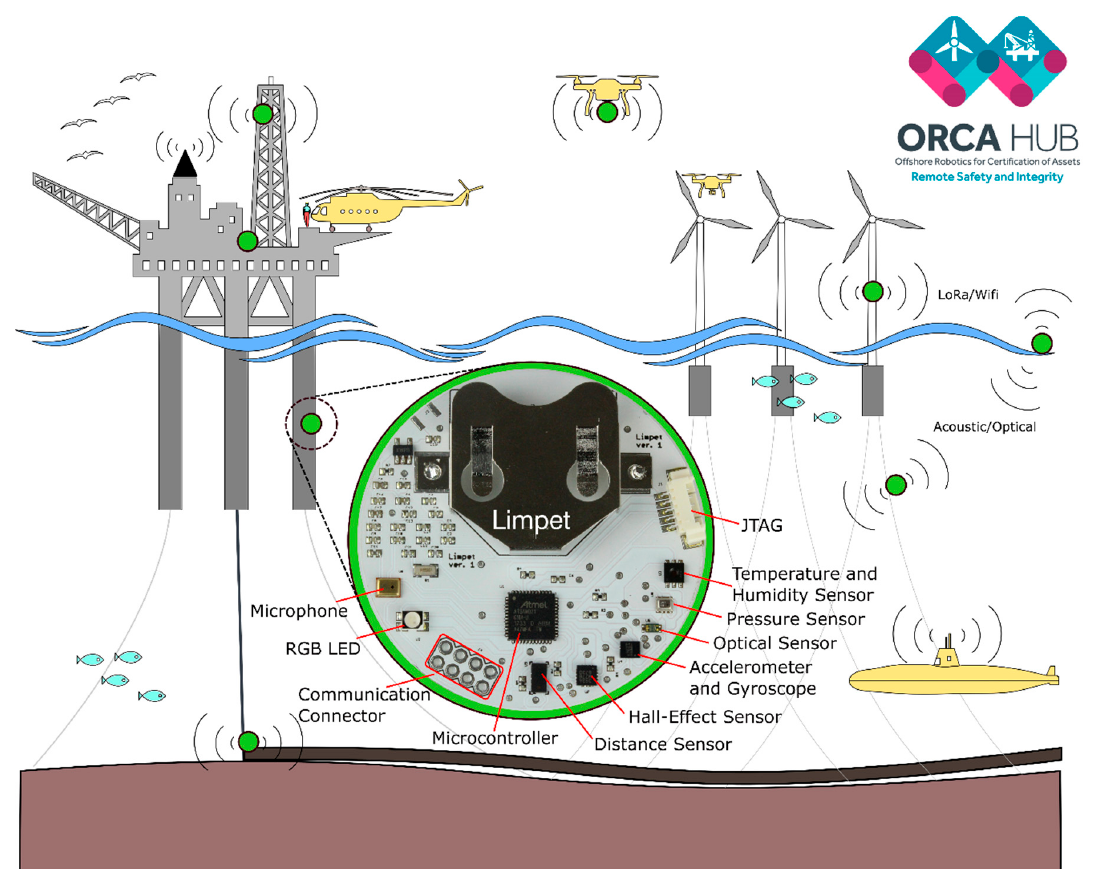
Figure 1. A conceptual overview of the ORCA Hub System. The Limpet, a part of the heterogeneous collection of robots that comprise the system, is shown in detail. The field robots and the Limpet communicate to each other, and the ORCA System controller, using Robot Operating System (ROS).